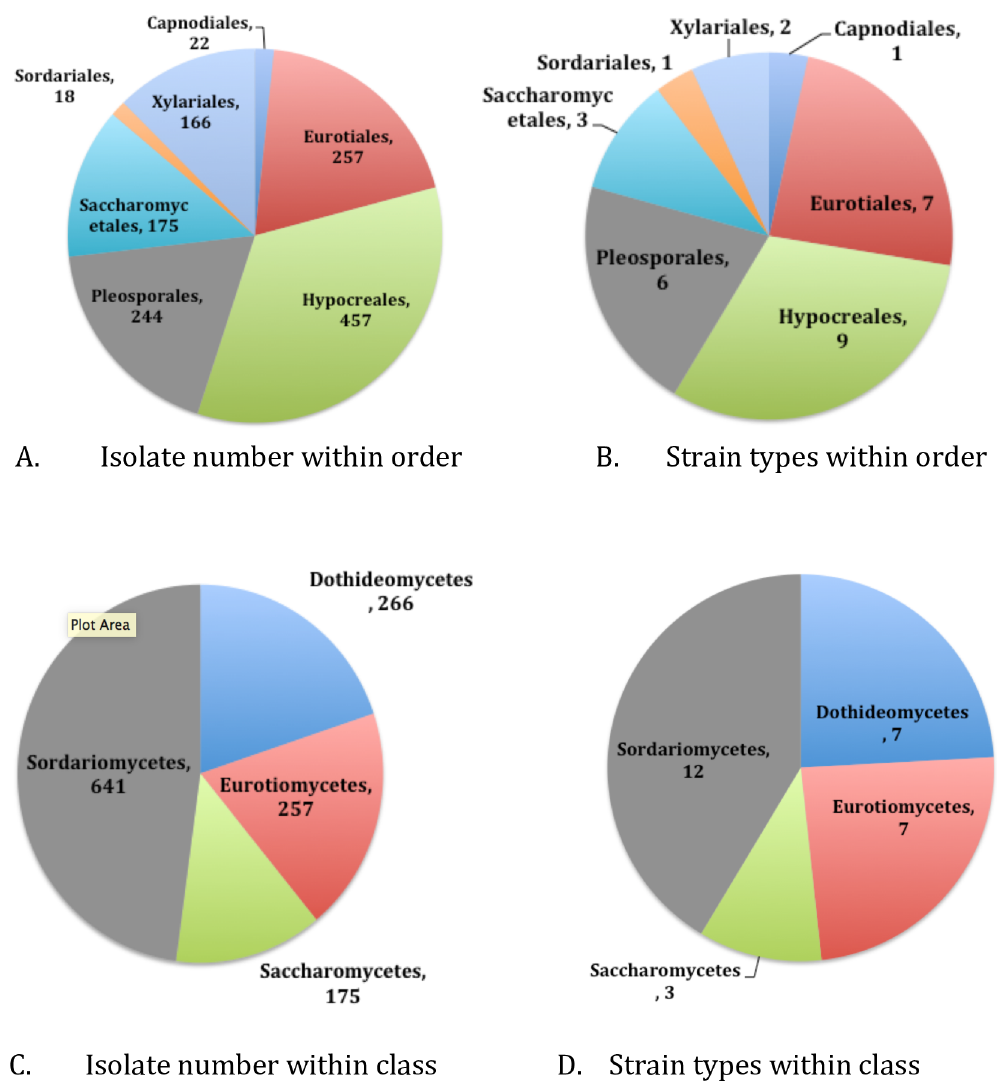
Fig 1. The distribution of endophytic fungal isolates from switchgrass. The isolate numbers (A) and strain types (B) at the order level; and the isolate numbers (C) and strain types (D) at the class level.